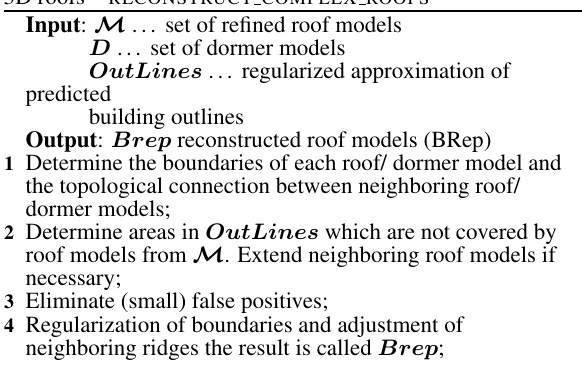
Algorithm 4: Pseudo-code for reconstruction of complex 3D roofs – RECONSTRUCT COMPLEX